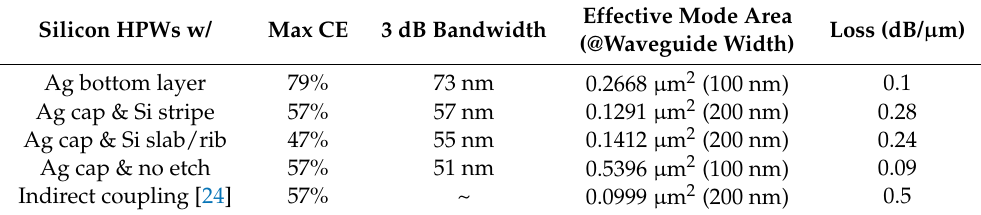
Table 1. Summary of the performances of the different sorts of silicon HPWs and the corresponding grating couplers investigated in this work. That of the indirect coupling scheme are also given for